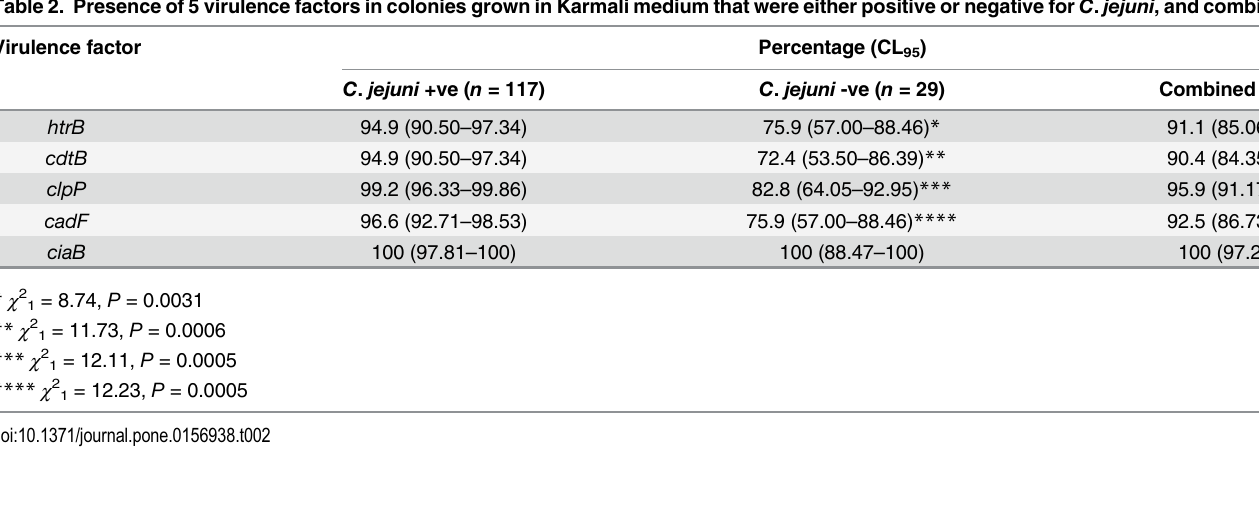
These values compare with a mean of just 0.84 ± 0.155 ( n = 75) among the C . jejuni -positive DNAs extracted from the BPW enrichment media of those chickens that failed to produce col- onies in Karmali medium. The difference in the number of virulence factors detected in the